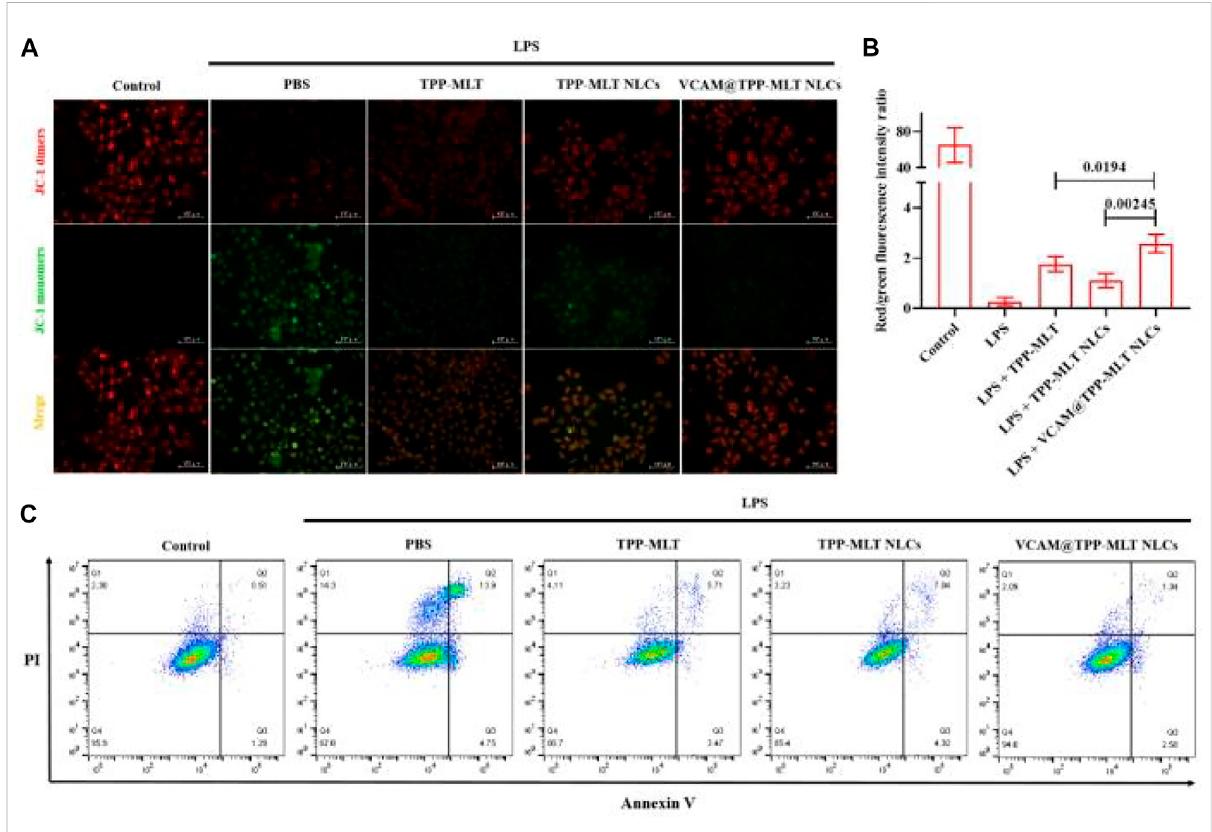
FIGURE 8 In vitro anti-apoptosis activity of VCAM@TPP-MLT NLCs. (A) Representative fl uorescence images of JC-1 assay to measure mitochondrial membrane depolarization in LPS-induced HUVECs (Scale bar, 100 μ m). (B) The ratio of fl uorescence intensity of JC-1 aggregates and JC-1 monomers in (A) . (C) Flow-cytometry-based apoptosis assay by Annexin-FITC apoptosis